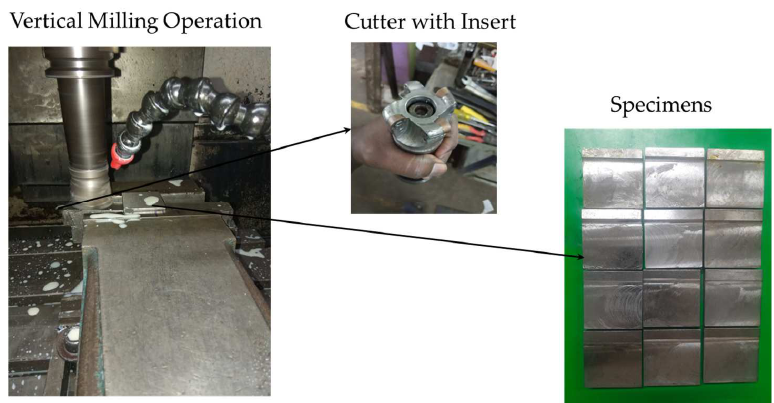
Figure 3. Vertical milling machining setup